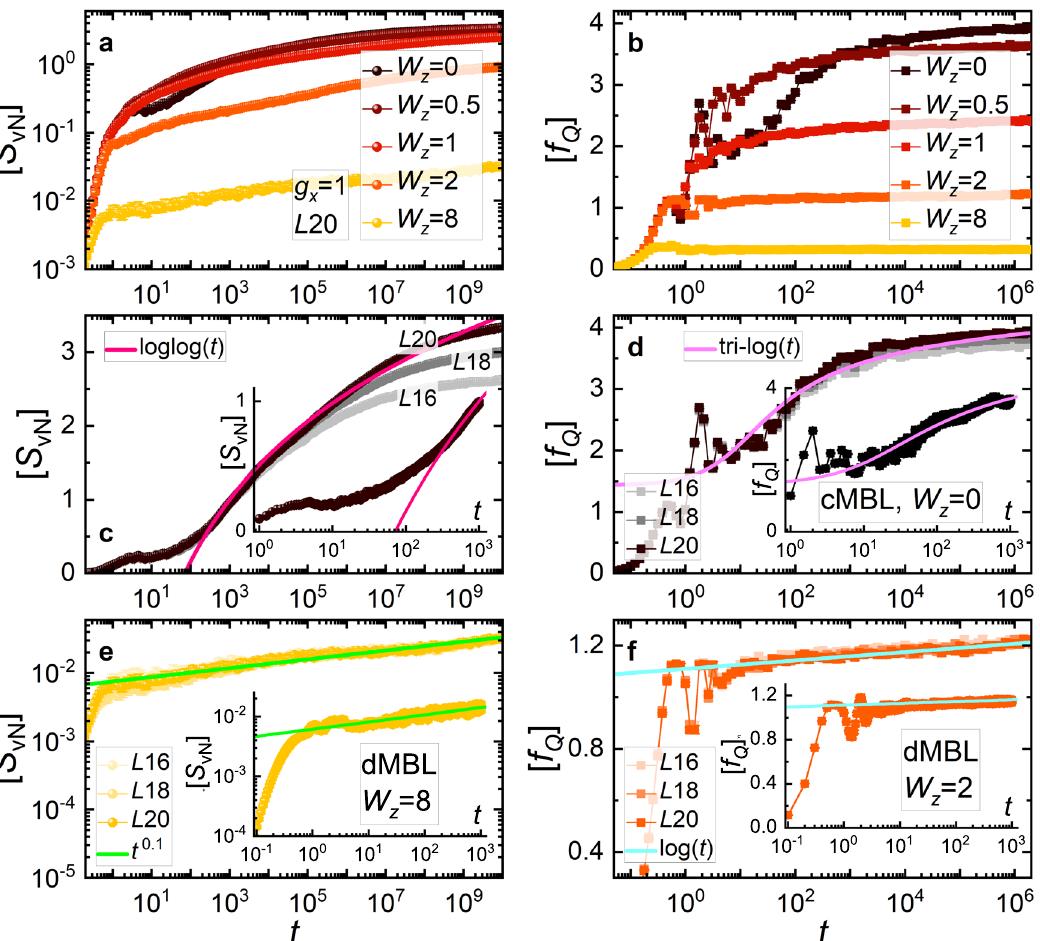
Fig. 5 cMBL-dMBL transition in dynamics with OBCs and fi xed g x = 1. The maximum chain length in ED is L = 20. The top row ( a , b ) summarizes functional changes of the growth of [ S vN ] and [ f Q ] as a function of W z . Fits in the middle row ( c , d ) suggest that for cMBL at W z = 0, the entanglement (QFI) growth follows a double (triple) logarithmic form. The bottom row ( e , f ) targets the dynamics of dMBL at large W z : consistent with the logarithmic rise of [ f Q ], [ S vN ] grows as a power law of t in dMBL. The four insets of c – f present the corresponding TEBD results of L = 28.